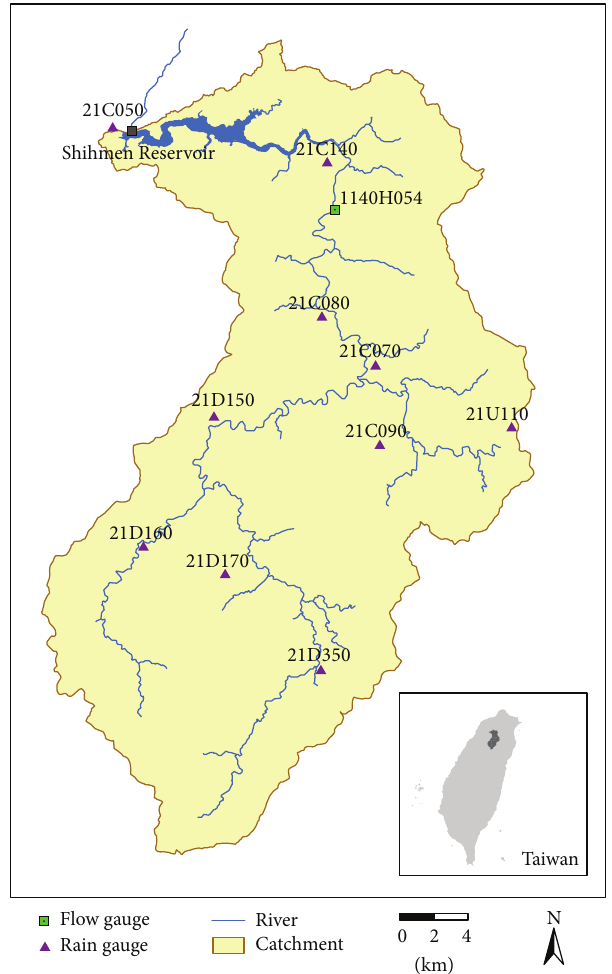
Figure 2: Study area and location of streamflow and precipitation